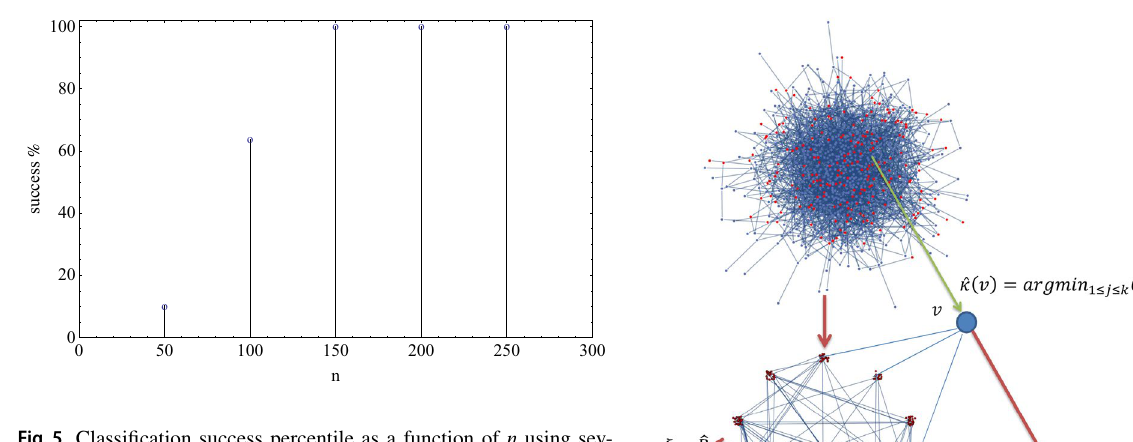
Fig. 5 Classification success percentile as a function of n using sev- eral repetitions of experiments and 1000 classification instances for each. Already a sample with 200 nodes generates a model with almost a perfect classifier